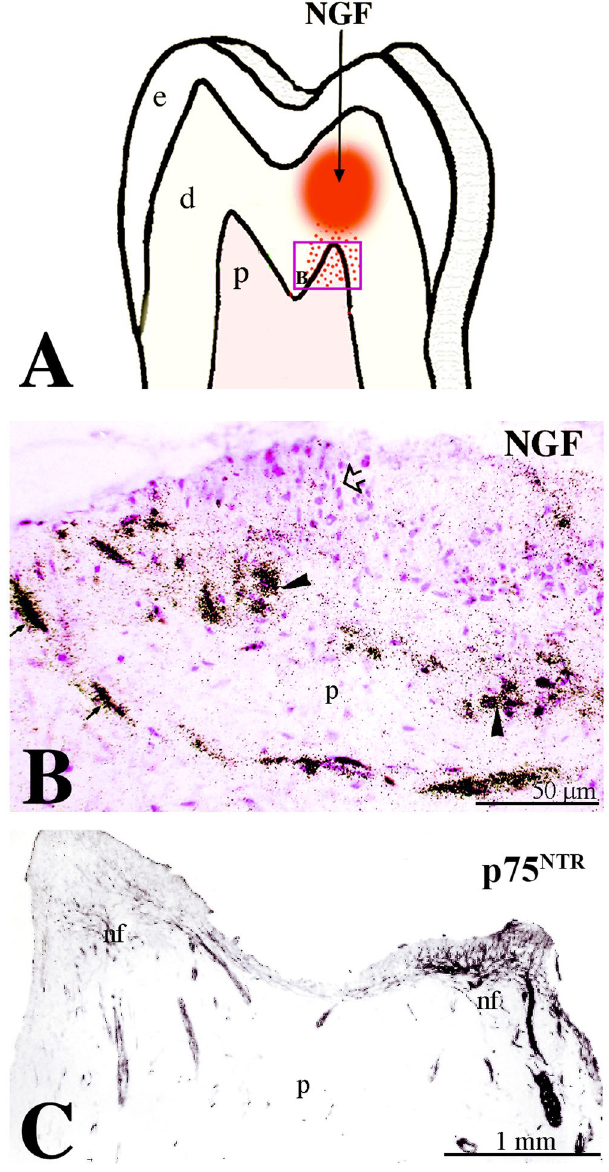
Figure 7. Administration of radioactive NGF ( 125 I-NGF) induces nerve growth towards the release site. ( A ) Schematic representation of the experimental approach for 125 I-NGF infusion. ( B ) Detection of 125 I-NGF diffusion in the pulp. ( C ) p75 NTR expression marking neurites growth towards the site of NGF infusion. Abbreviations: nf, nerve fibres; p,